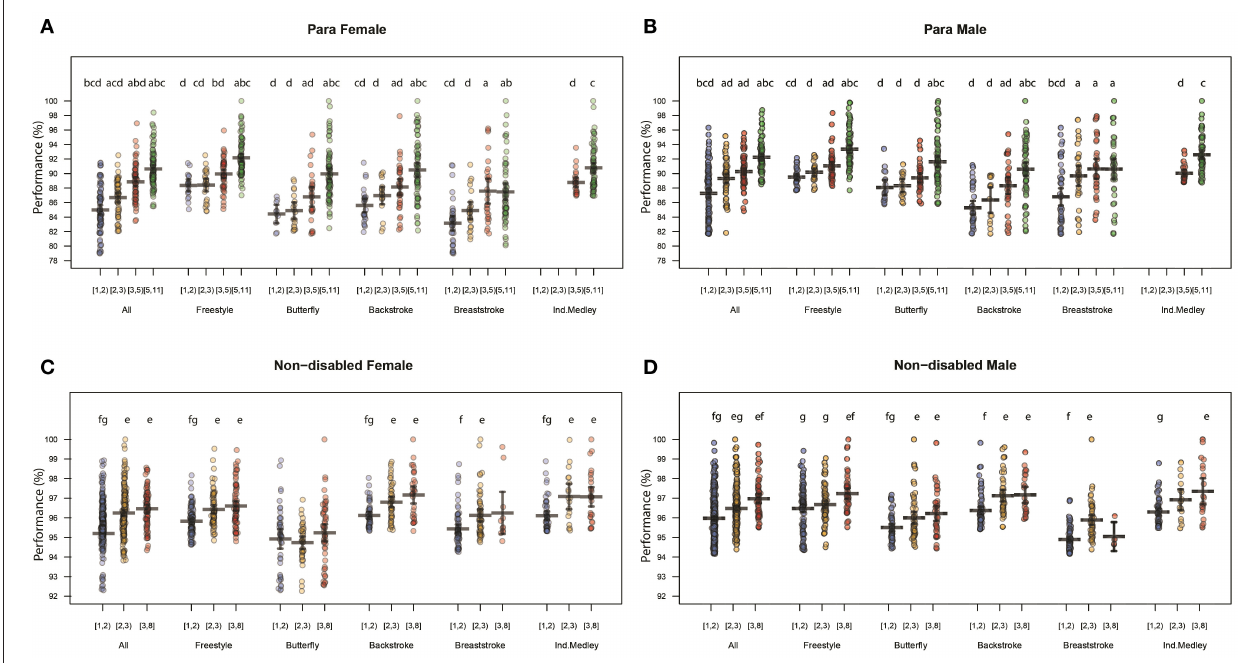
FIGURE 4 | Mean performance ( ± SD ) as a percentage (%) of the best performance based on the number of events in which swimmers involved, by stroke for Para female (A) and Para male (B) , non-disabled female (C) , and non-disabled male (D) swimmers. A letter indicates a significant performance difference between 2 groups of events ( p < 0.05). The following letters correspond to the Para swimmers’ group based on number of events: a [1,2); b [2,3); c [3,5); d [5,11]. The following letters correspond to the non-disablec swimmers’ group based on number of events: e [1,2); f [2,3); g [3,8].